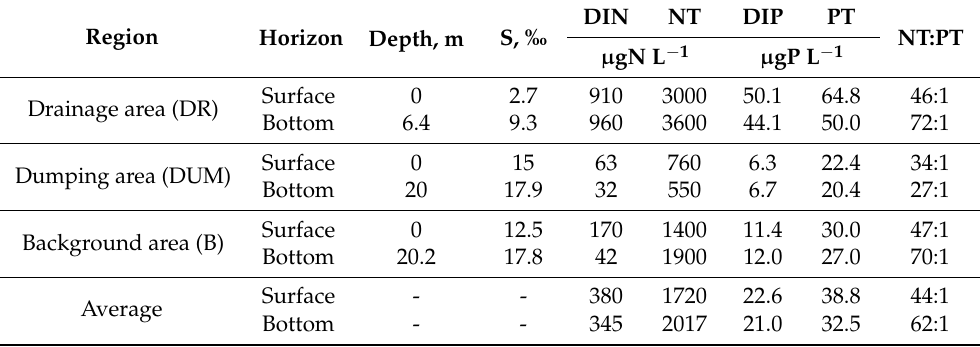
Table 2. Average data of the depth, salinity and nutrients in the Ukrainian part of Danube nearshore area in August